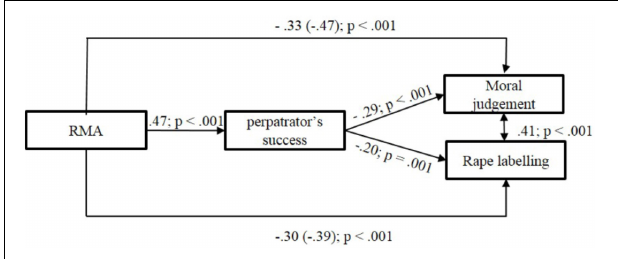
FIGURE 1 | Standardized path model of the direct and indirect effects on Moral judgment and Rape labeling in Study